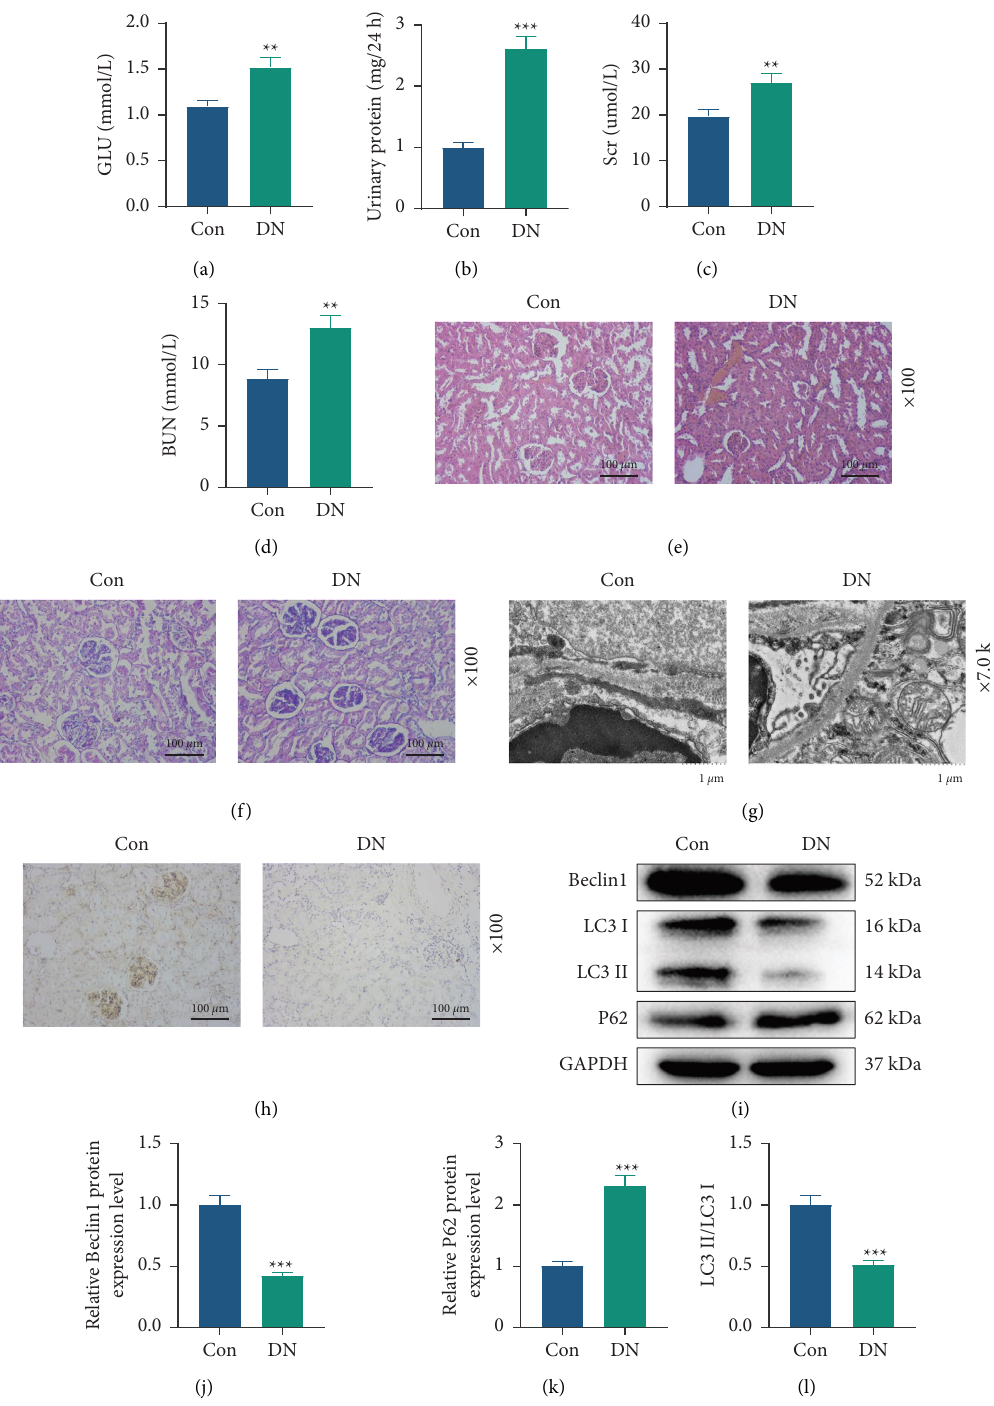
Figure 1: Detection of biochemical indexes, pathological changes, and autophagy-related proteins in DN mice and normal mice. C57BL/6 mice were treated with 50mg/kg STZ in citrate bufer (DN group) for 5 consecutive days or treated with citrate bufer (control group). (a) Te whole-blood GLU was measured using a blood GLU meter. (b) Te urinary protein concentration was determined by the corresponding kit. (c) and (d) SCR and BUN levels were detected using an automatic biochemical analyzer. (e) Hematoxylin and eosin staining of kidney tissues (magnifcation:100x times; scale bar � 100 μ m). (f) PAS staining of kidney tissues (magnifcation:100x times; scale bar � 100 μ m). (g) Renal podocytes were observed by a transmission electron microscope (magnifcation: 7000x times; scale bar � 1 μ m). (h) Immunohis- tochemistry was used to detect the expression of LC3 in kidney tissues (magnifcation 100x times; scale bar � 100 μ m). (i)–(l) Te protein levels of Beclin 1, LC3 I/II, and P 62 in kidney tissues were detected by Western blot. GAPDH was used as the internal control. Quantifed values were presented as mean ± standard deviation of at least three independent experiments. ∗ p < 0 . 01, ∗∗ p < 0 . 001 vs. control. STZ: streptozotocin. DN: diabetic nephropathy. GLU: glucose. SCR: serum creatinine. BUN: blood urea nitrogen. GAPDH: glyceraldehyde-3- phosphate dehydrogenase. PAS: periodic acid